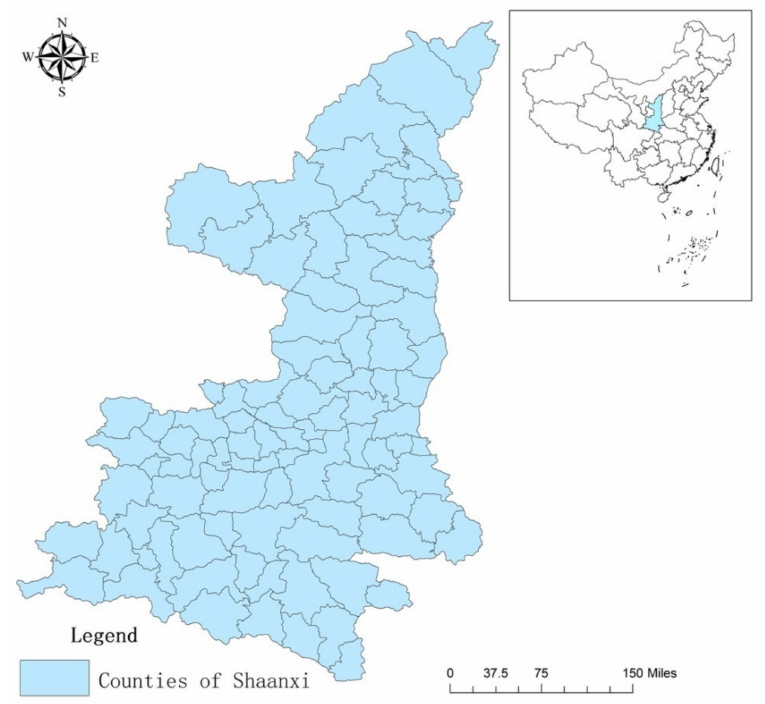
Figure 1. Study area in arid